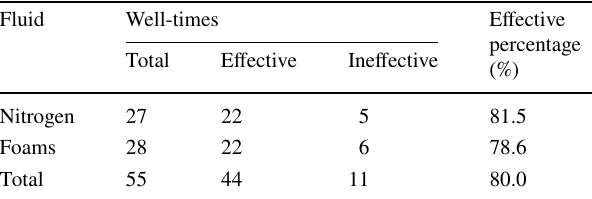
Table 6 The applications of improvement measure for low production wells Fluid Well-times Effective Nitrogen